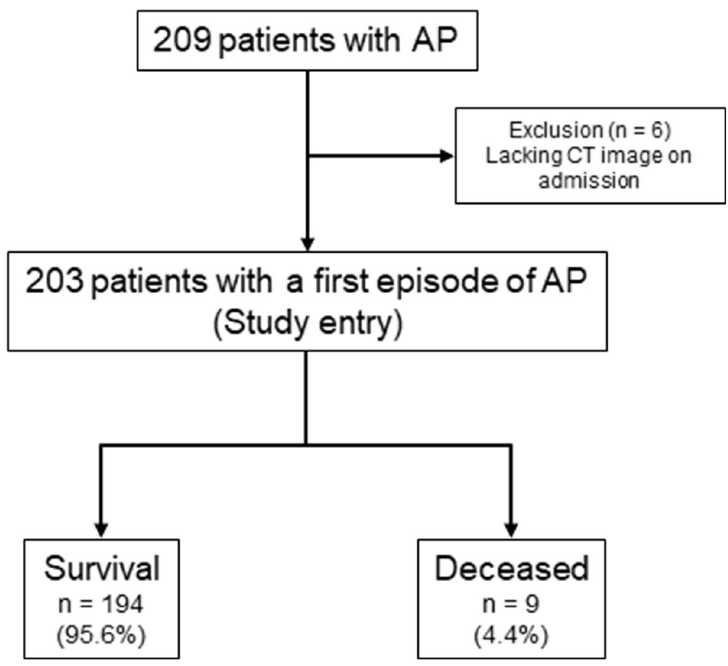
Fig 1. Flow diagram of patients with acute pancreatitis. AP , acute pancreatitis; CT , computed tomography.